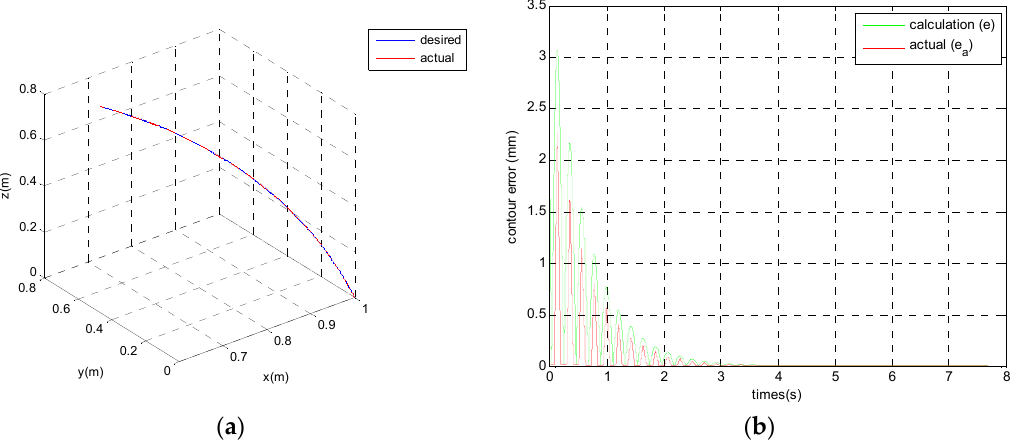
Figure 6. Comparison of actual and calculation contour errors, ( a ) trajectories; ( b ) contour errors.